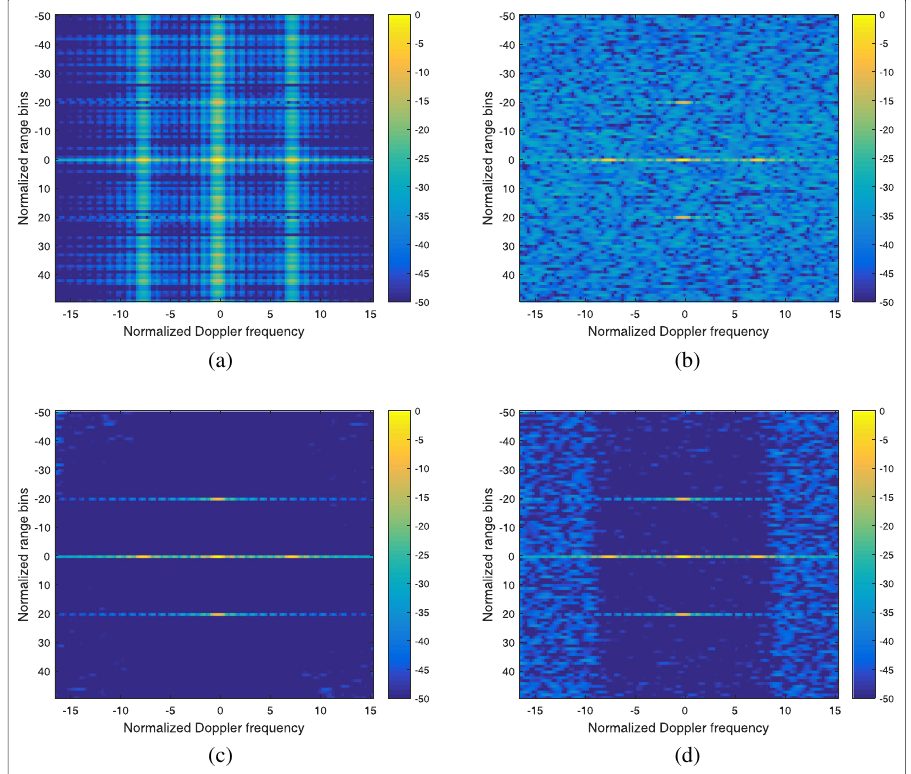
Fig. 3 Range-Doppler processing results by using Golomb sequence, random sequences, and sequence set optimized by SVD-USSD and CA-USSD algorithms: a Golomb sequence, b random sequences, c sequence set optimized by SVD-USSD algorithm, and d sequence set optimized by CA-USSD